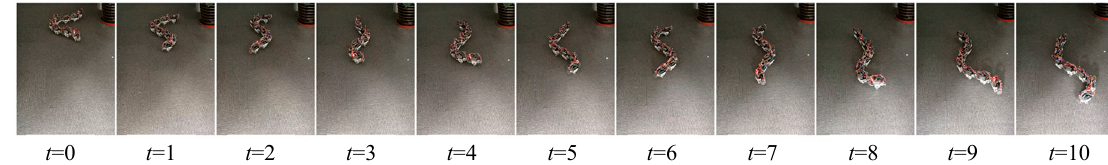
Figure 10. Snapshots of forward serpentine locomotion.